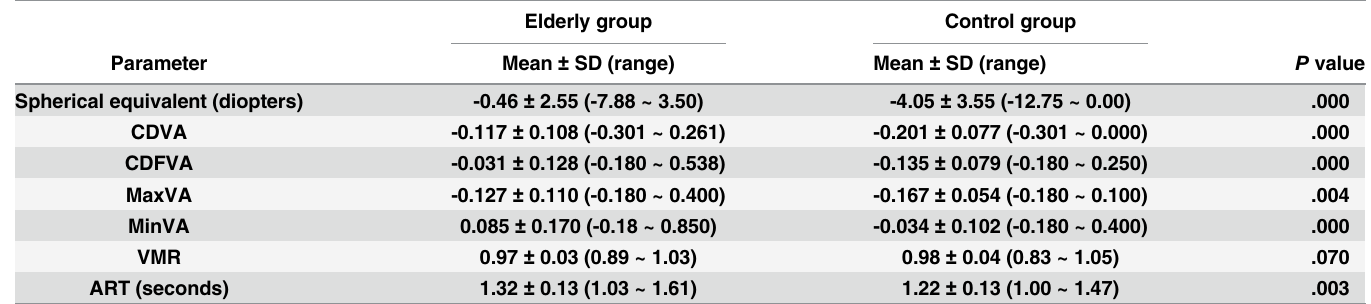
Table 1. Refraction and visual